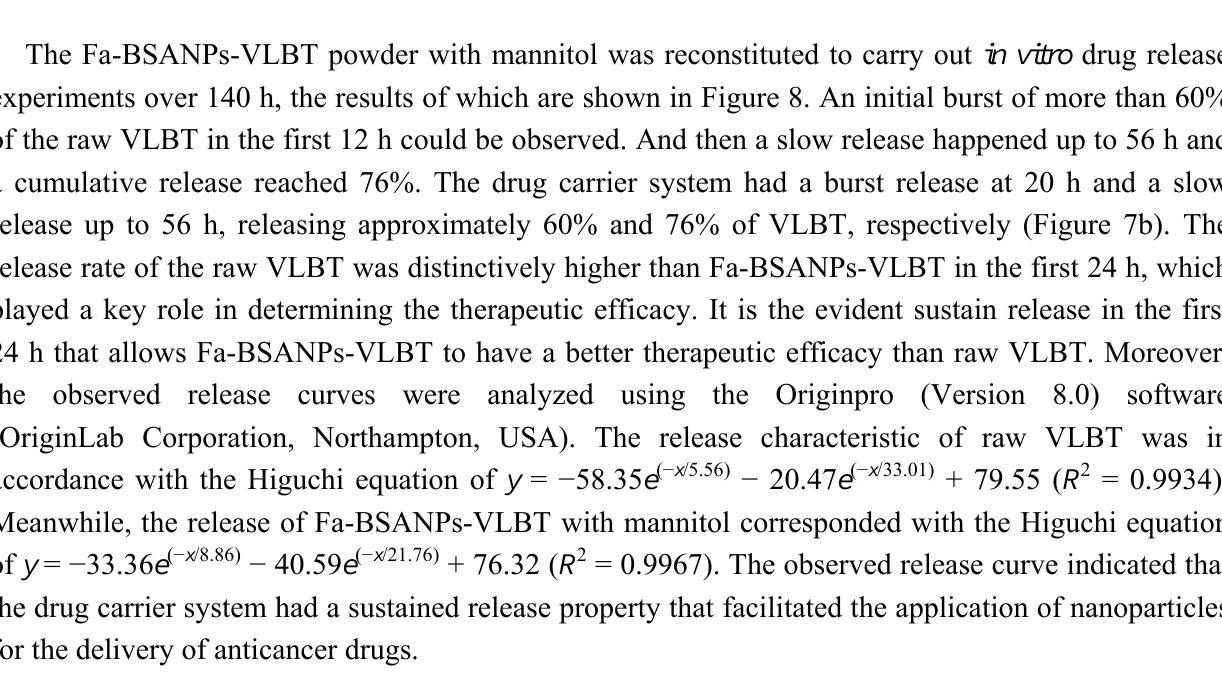
Figure 8. The release profiles of raw VLBT and Fa-BSANPs-VLBT with mannitol. ( a ) Raw VLBT; ( b ) Fa-BSANPs-VLBT with